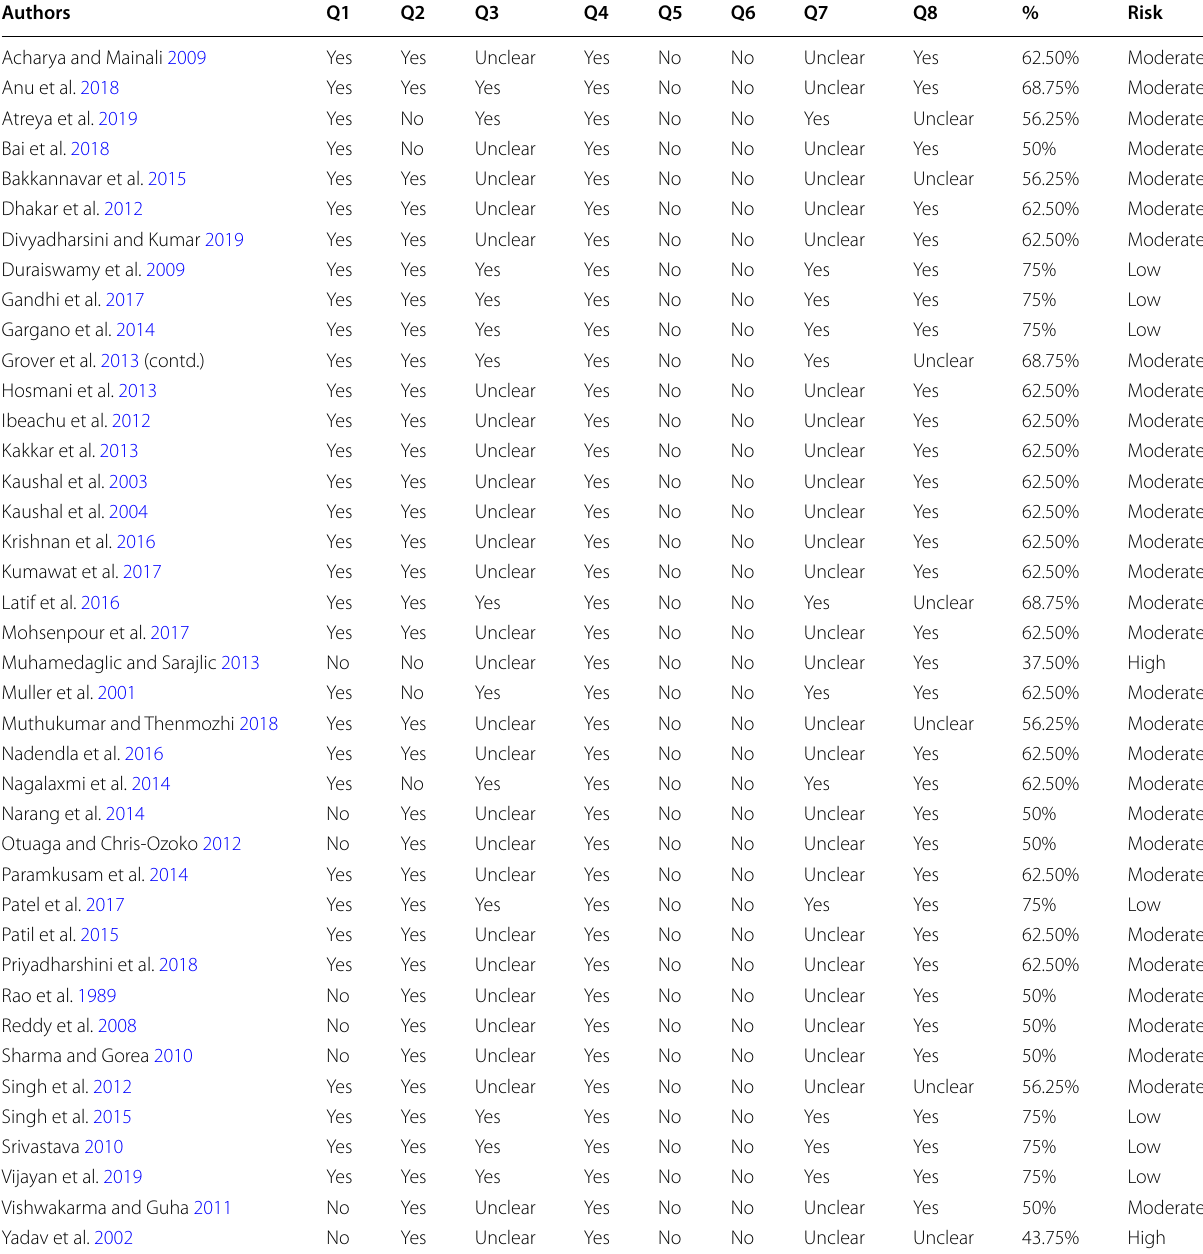
Table 6 Outcomes of the assessment of the risk of bias within eligible cross-sectional